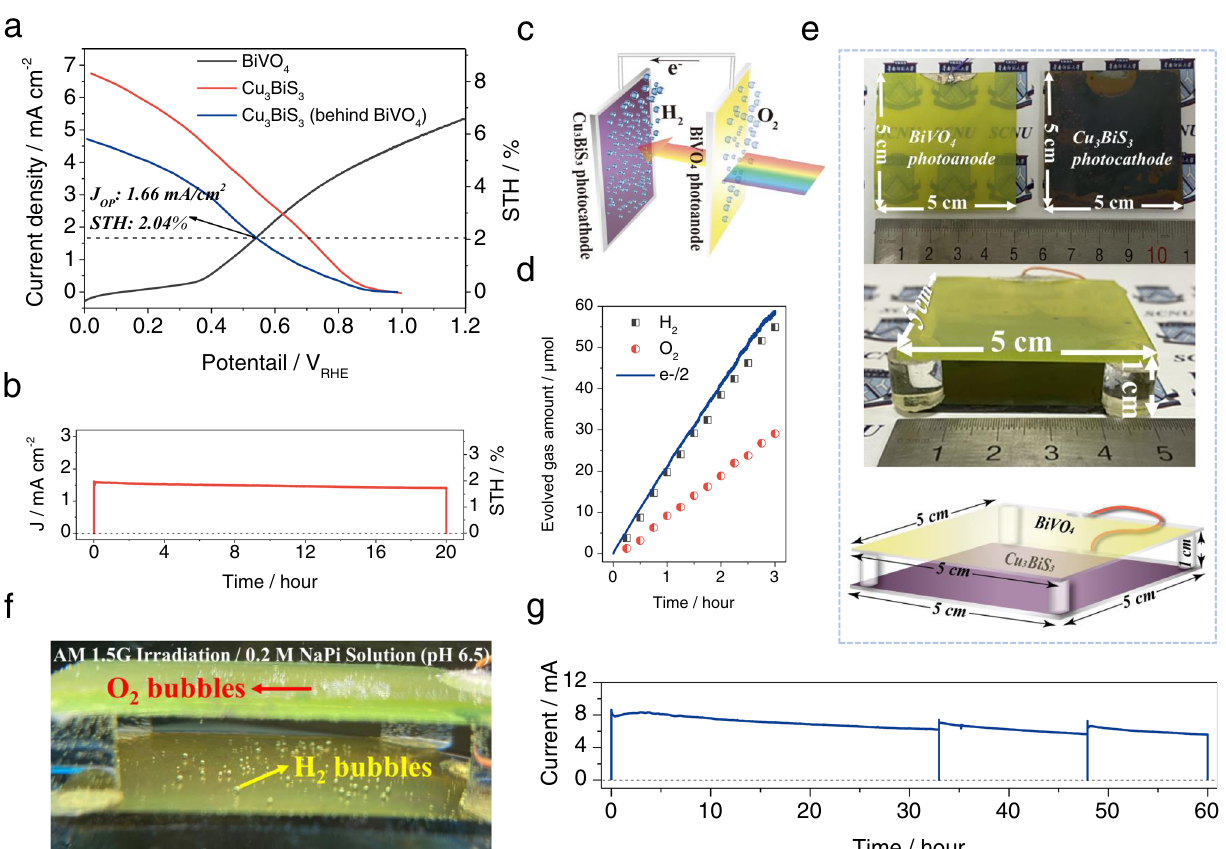
Fig. 4 PEC performance of the scalable Cu 3 BiS 3 -BiVO 4 tandem device. ( a ) J – V curves of the Cu 3 BiS 3 photocathode, BiVO 4 photoanode and Cu 3 BiS 3 photocathode behind the BiVO 4 photoanode. (Jop: the operation point photocurrent density, STH: solar to hydrogen ef fi ciency). ( b ) Photocurrent density- time curve, ( c ) working diagram and ( d ) hydrogen and oxygen evolution amount-time curves of the Cu 3 BiS 3 -BiVO 4 tandem device. ( e ) Photographs of the 5 × 5 cm 2 Cu 3 BiS 3 photocathode, 5 × 5 cm 2 BiVO 4 photoanode and large area (5 × 5 cm 2 ) Cu 3 BiS 3 -BiVO 4 tandem device and diagram of the large area (5 × 5 cm 2 ) Cu 3 BiS 3 -BiVO 4 tandem device. ( f ) Working photograph of the large area (5 × 5 cm 2 ) Cu 3 BiS 3 -BiVO 4 tandem device under solar simulated AM 1.5 G irradiation. ( g ) Photocurrent density-time curve of the large area (5 × 5 cm 2 ) Cu 3 BiS 3 -BiVO 4 tandem device. All measurements were carried out in a 0.2 mol/dm 3 Na 2 HPO 4 /NaH 2 PO 4 solution (pH = 6.5) under solar simulated AM 1.5 G irradiation. Source data are provided as a Source Data fi